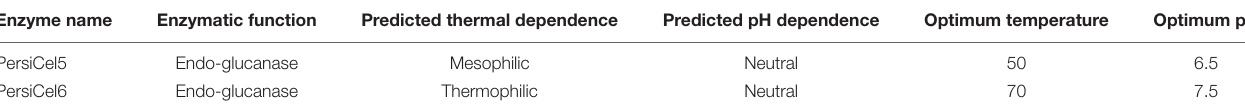
TABLE 2 | Two novel cellulolytic enzymes were discovered from camel rumen metagenome and are being investigated in other studies. This table represents the detected enzymatic function of each enzyme and the comparison of predicted dependence characteristics with real pH and temperature optima values. MCIC was able to correctly predict the desired